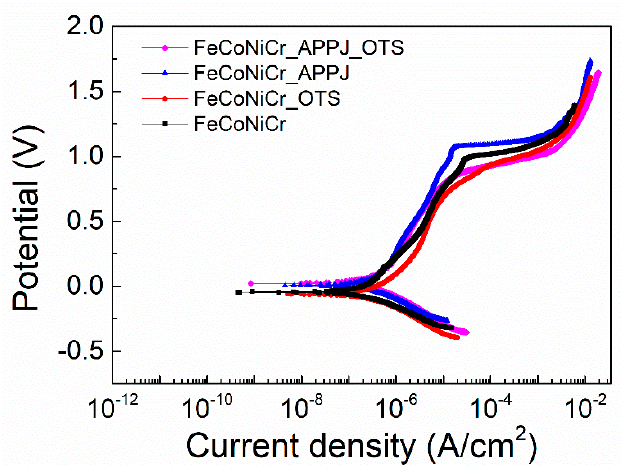
( d ) Figure 3. Water contact angles of ( a ) FeCoNiCr medium-entropy alloy (MEA), ( b ) APPJ-treated FeCoNiCr MEA, ( c ) OTS-coated APPJ-treated FeCoNiCr MEA, and ( d ) OTS-coated FeCoNiCr MEA. Figure 4 shows the potentiodynamic polarization curves. FeCoNiCr, FeCoNiCr_OTS, FeCoNiCr_APPJ, and FeCoNiCr_APPJ_OTS represent bare, OTS-coated, APPJ-treated, and OTS- coated APPJ-treated FeCoNiCr MEAs, respectively. Table 1 lists the corresponding corrosion potential (Ecorr), corrosion current density (Icorr), pitting potential (Epit), and passive region (Epit- Ecorr) values determined with methods described in [45,46]. As shown from the table, APPJ treatment can increase pitting potential and passive region range of FeCoNiCr MEA. In addition, APPJ treatment also reduces the current density in the passive region. This enhancement in anti- corrosion properties can be attributed to the formation of metal oxides on the surface of FeCoNiCr MEA. However, the lower pitting potential and narrower passive region were observed in OTS- coated APPJ-treated FeCoNiCr MEA sample. It is plausible that the ultrasonication during OTS coating may produce defects on part of the loosely grown oxides during APPJ treatment. Nevertheless, APPJ treatment increases Ecorr from − 0.045 V to 0.006 V. OTS coating does not drastically affect the corrosion potential and the current density in the passivation area compared with the bare and APPJ-treated MEAs. The OTS coating treatment after APPJ treatment improves the Ecorr further to 0.022 V, however, the passive region drops to a level worse than the one without any treatment. Following the analyses, although the OTS coating increases the water contact angle, as shown in Figure 3, it seems not to be a suitable protective layer to prevent corrosion. In the end, the APPJ-treated MEA shows the best anti-corrosion performance based on the indicators of the pitting potential and the width of the passive region range. Figure S1 shows the XRD results, and Table S1 summarized corresponding crystallinity information obtained from XRD results in Figure S1. After